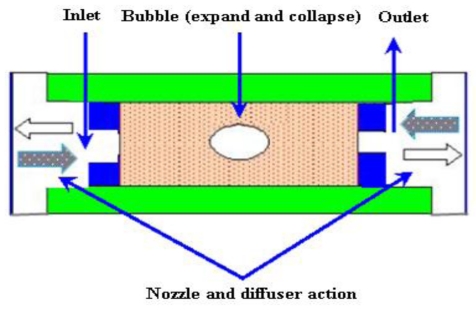
Bubble micropump.